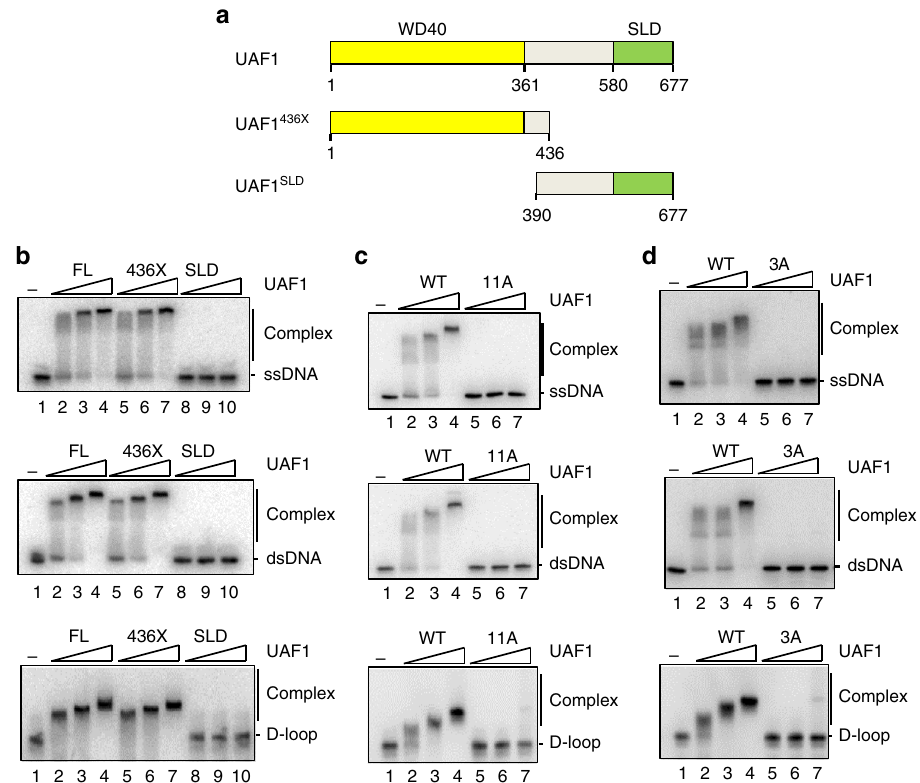
Fig. 2 Biochemical analysis of UAF1 DNA binding mutants. a UAF1 fragments tested for DNA binding. Numbers indicate the positions of amino acid residues. b UAF1 (FL), UAF1 436X and UAF1 SLD (100, 200 and 400 nM) were tested for the binding of ssDNA, dsDNA, or D-loop (10 nM). c UAF1 (WT) and UAF1 11A (11A) (200, 400, and 800 nM) were tested for the binding of ssDNA, dsDNA, or D-loop as in b . d UAF1 (WT) and UAF1 3A (3 A) were tested for the binding of ssDNA, dsDNA or D-loop as in